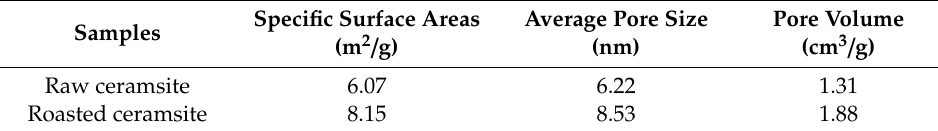
Table 2. The physical properties of the waterworks sludge ceramsite.